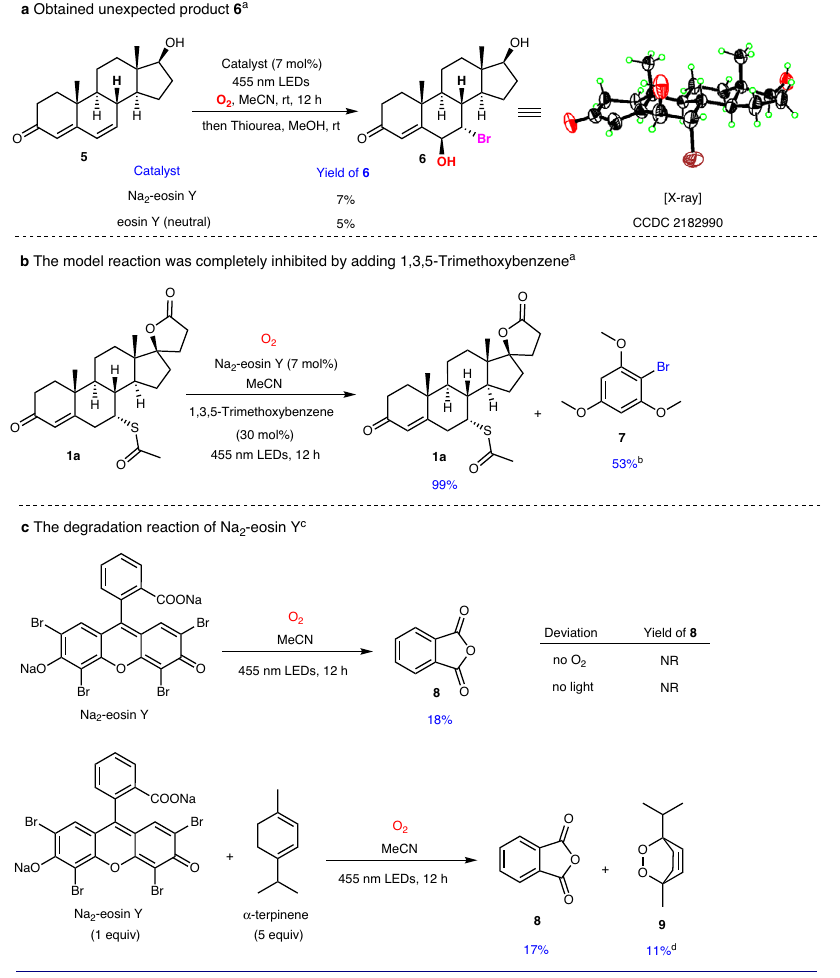
Fig. 7 | Selected mechanism studies. a Obtained unexpected bromide product 6 . b Bromine trapping experiment. c The degradation reaction of Na 2 -eosin Y. a Reactions performed on 0.20mmol scale with dimethyl terephthalate as an